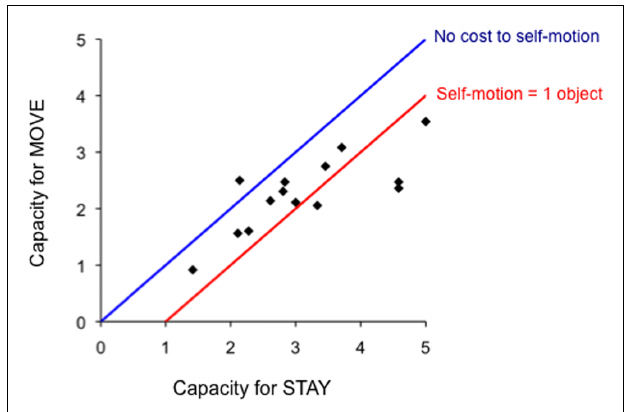
FIGURE 2 | Estimates of tracking capacity (C) for each participant in the move and stay conditions. The blue line shows the perfect one-to-one relationship that would occur if tracking capacity was unaffected by self-motion.The red line shows a perfect cost of one object due to